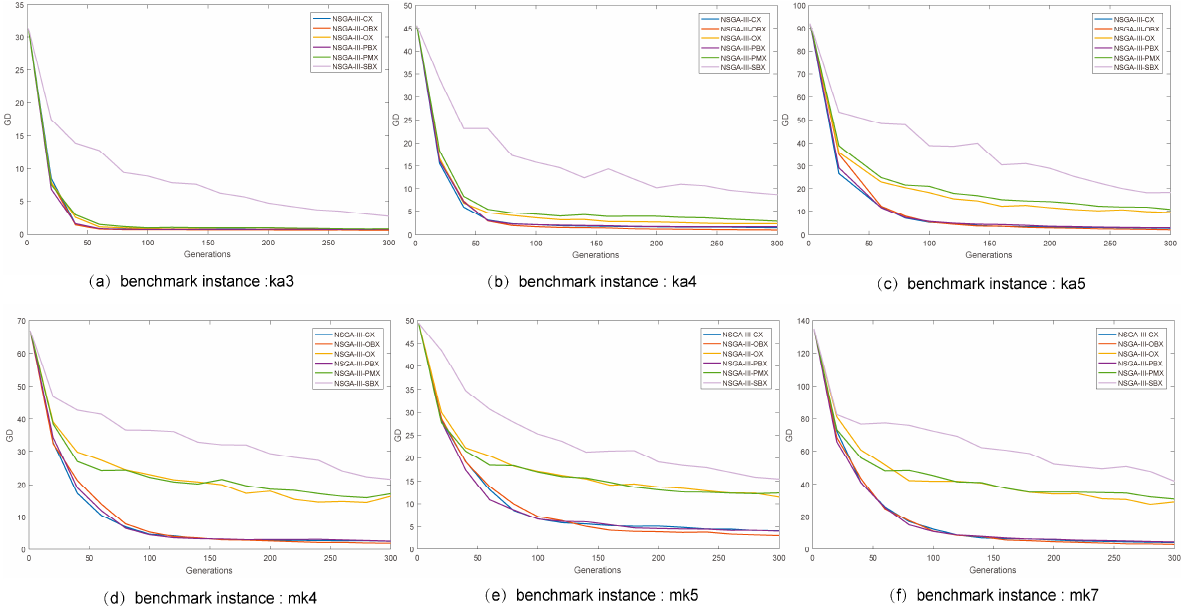
Figure 2. At population size of 200, the evolutionary trajectory of the generational distances (GDs) of the NSGA-III variants on the six FJSP instances (the average of the results of 30 independent runs; the initial population is a random population).